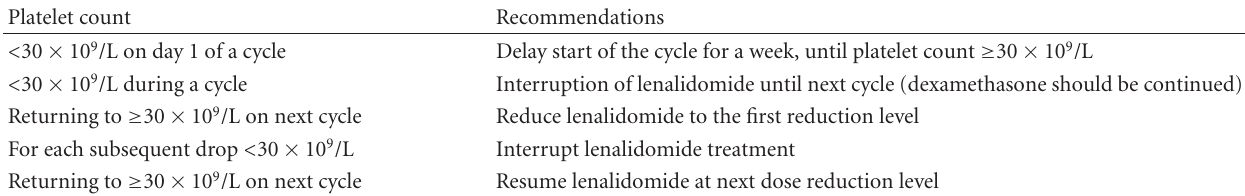
Table 4: Lenalidomide dose adjustment for